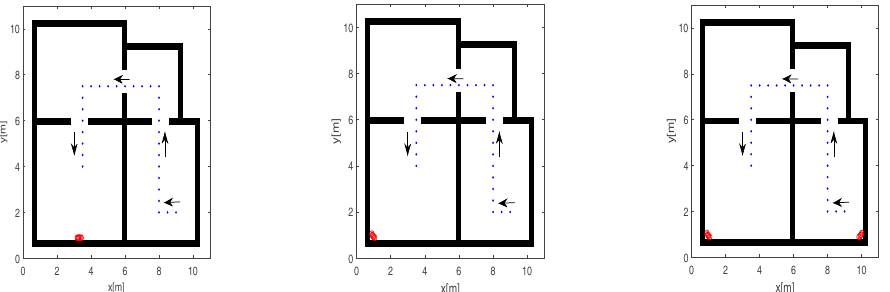
Figure 3. Geometry of the scenario and array configurations. The red circles indicate the receiving antennas and the blue points denote the positions of the RF source along its path. Horizontal array configuration ( left panel ). Tilted-array configuration ( middle panel ). Two-tilted arrays configuration ( right panel ).